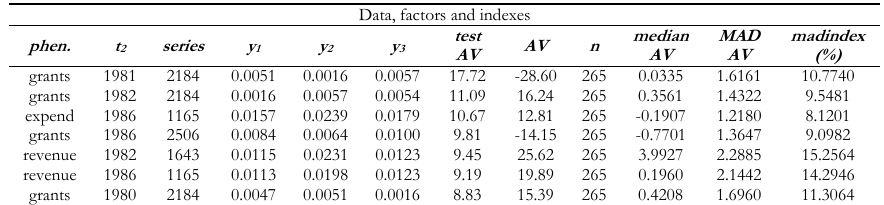
Output of washer.AV() for Dahlberg and Johanssen (2000) data Data, factors and indexes